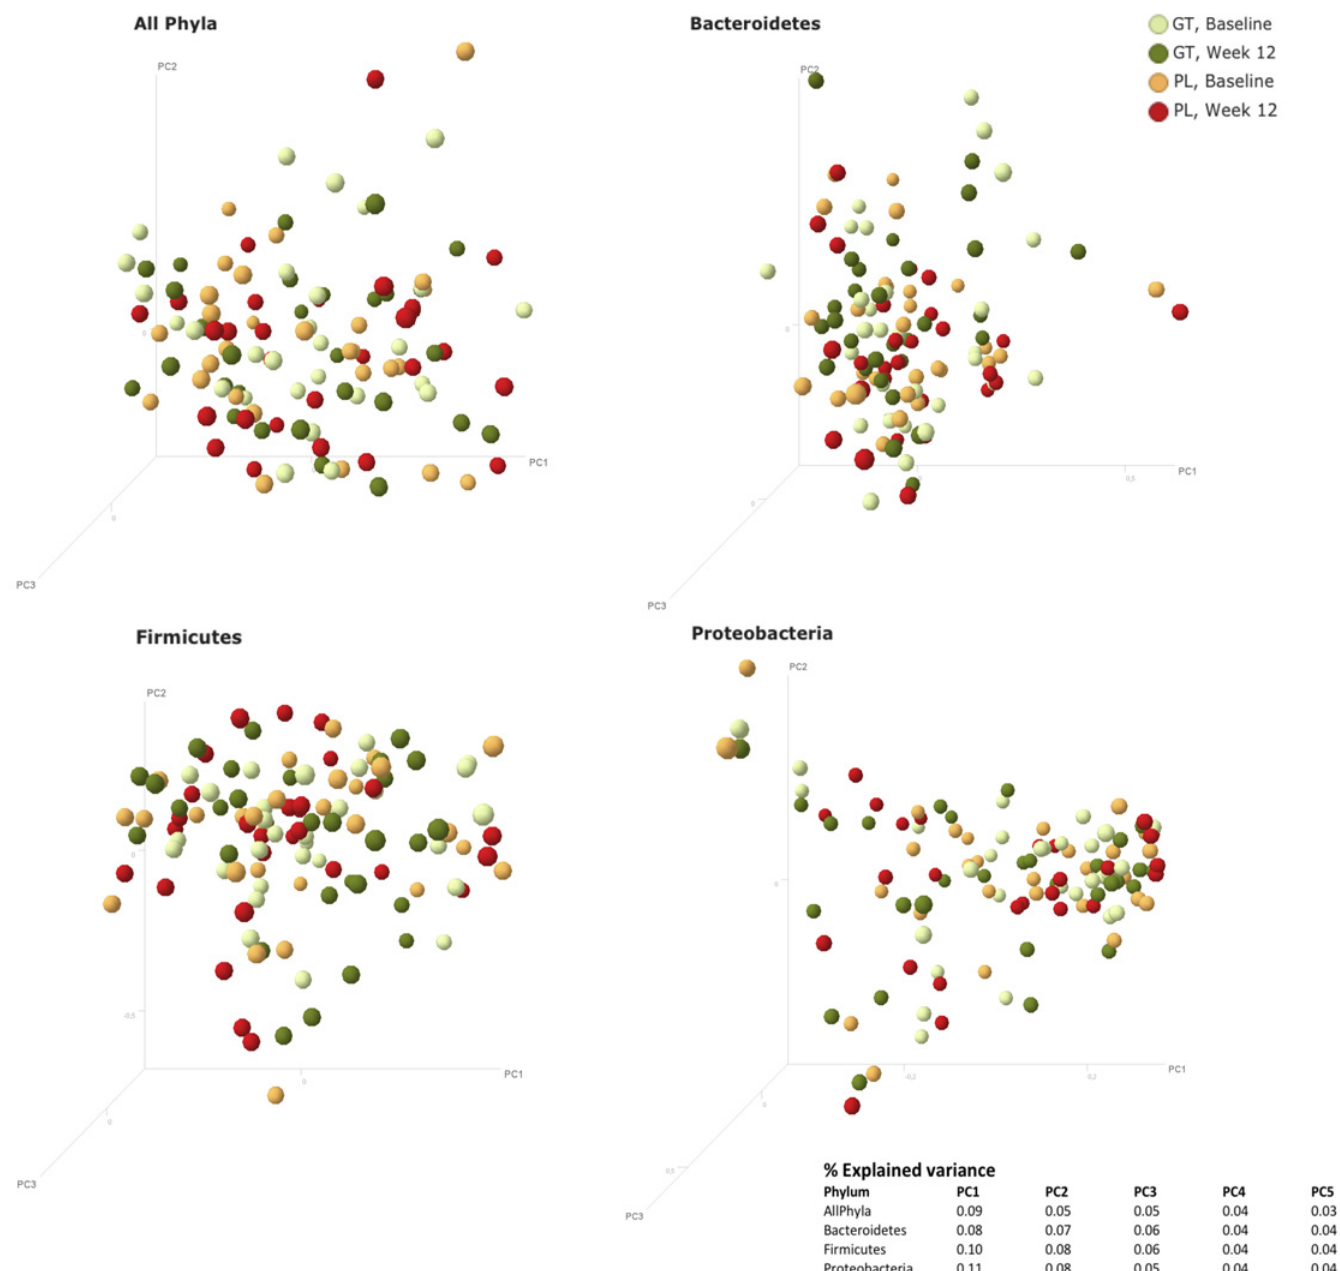
Fig 4. Principal Coordinates Analysis (PCoA) plots of Bray Curtis distances between samples, with the %explained variance by the principle coordinates. PCoA per phylum, Bray Curtis, log2, n =